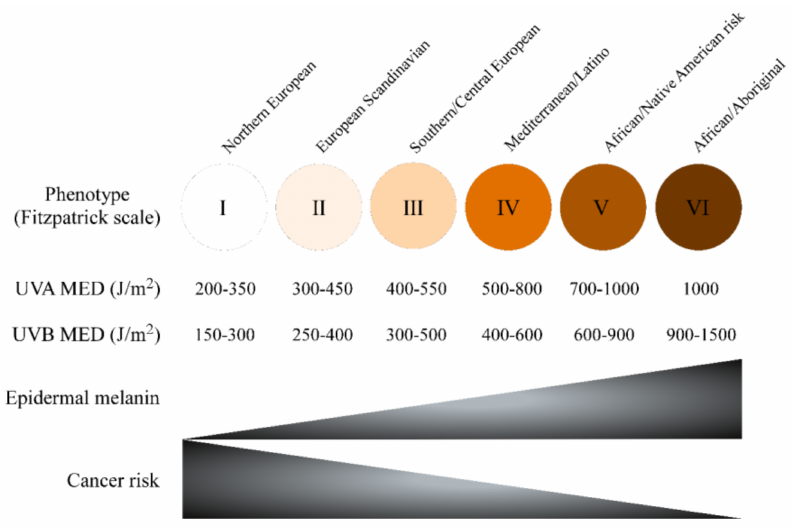
Figure 4. Influence of pigmentation and phototype on skin cancer